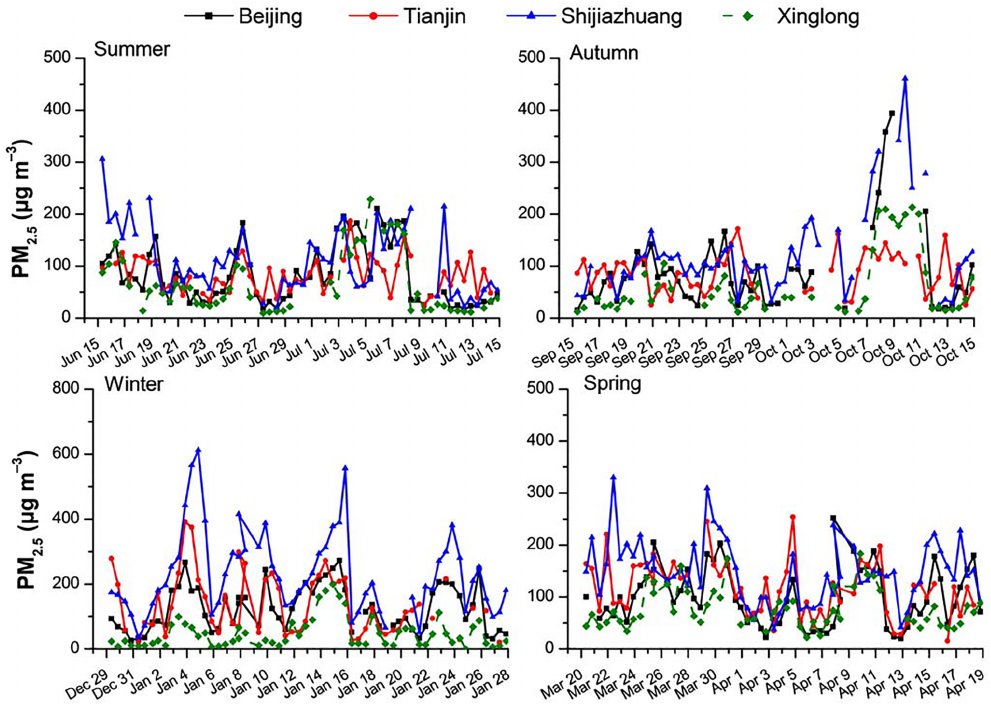
Figure 2. Time series of the gravimetric PM 2 . 5 concentrations during the four study